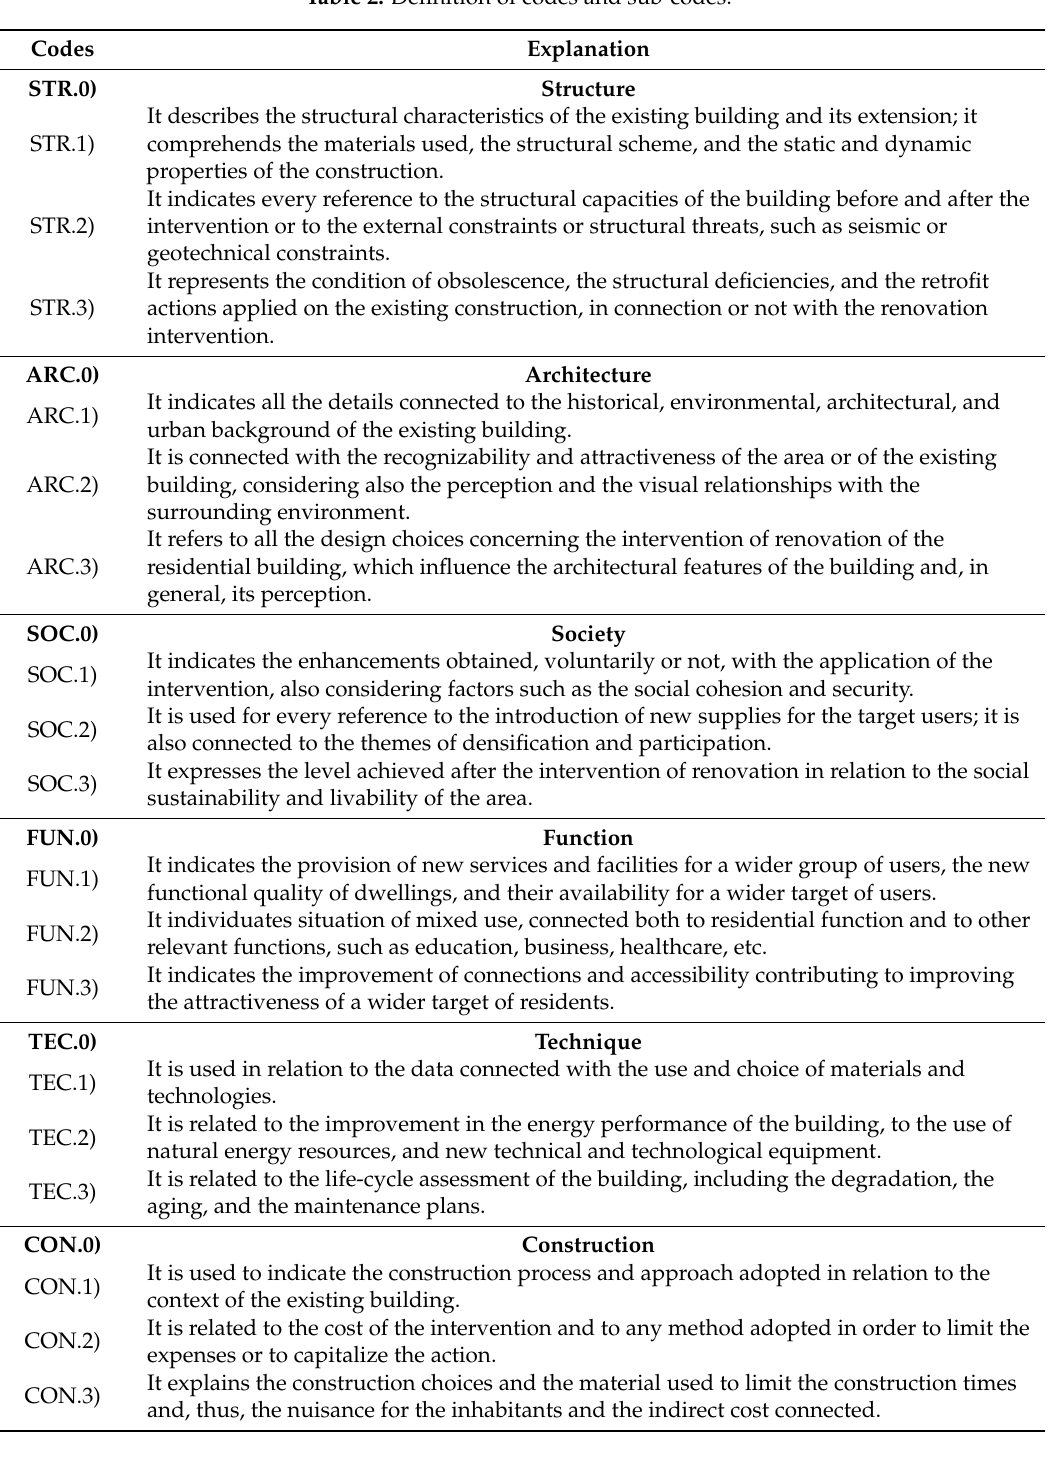
Table 2. Definition of codes and